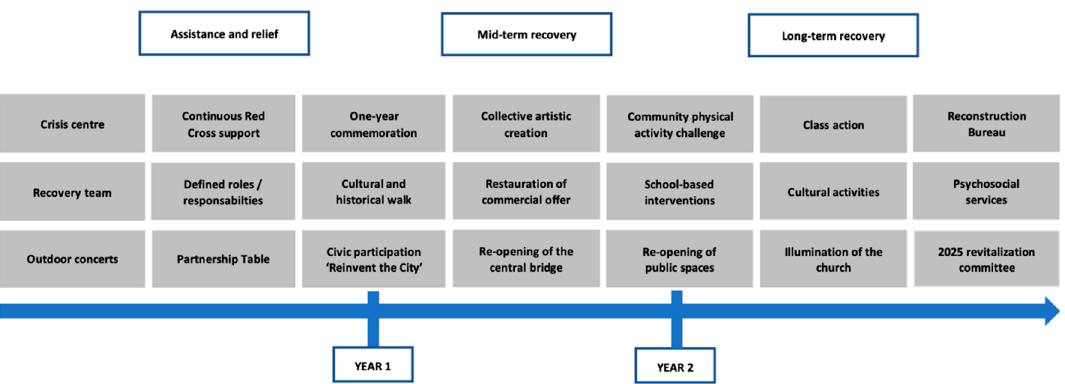
Figure 1. Historical timeline tracing key milestones in recovery of Lac-Mégantic community (March 2016) .